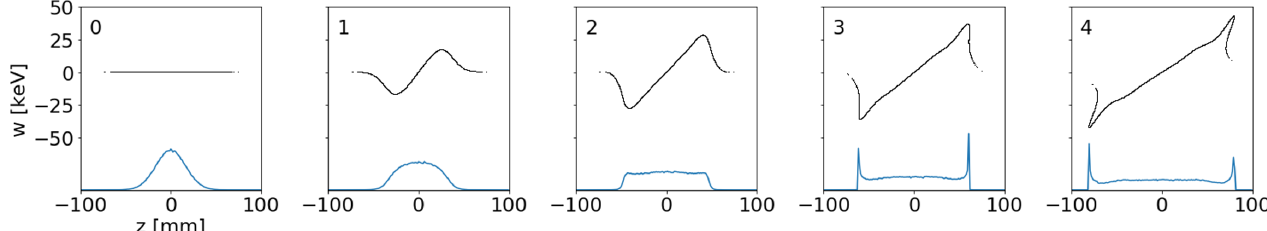
FIG. 3. Snapshots of phase space evolution in 1D longitudinal simulation at even intervals of 2.5 meter. A line-out of the spatial profile is also